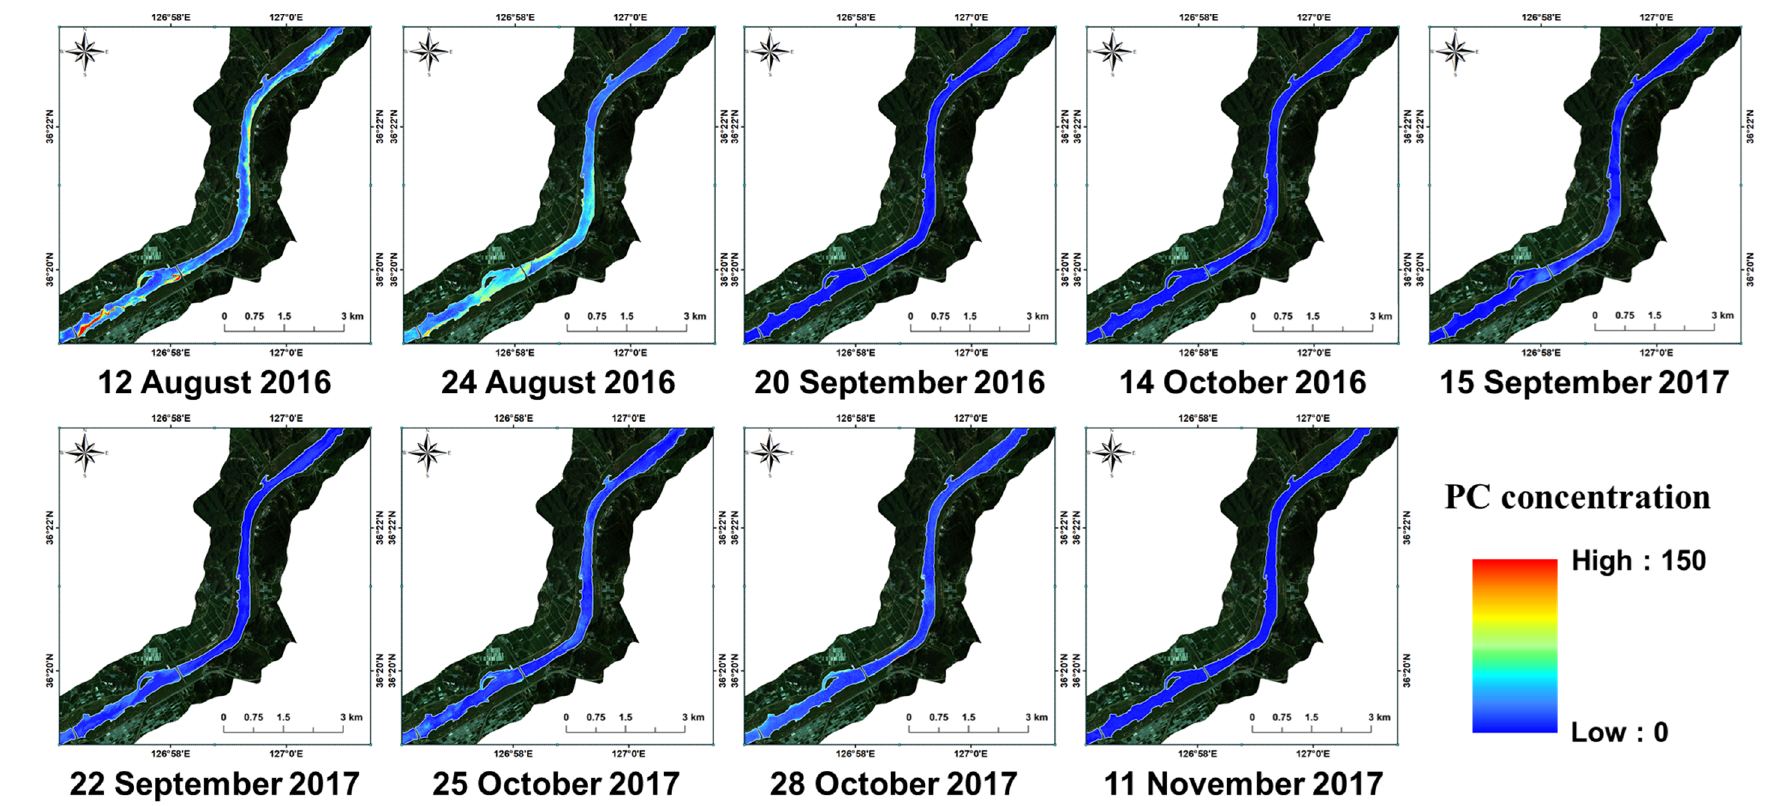
Figure 6. Spatio-temporal change estimation of phycocyanin concentration by applying artificial neural network to the hyperspectral imagery of the nine sampling dates.